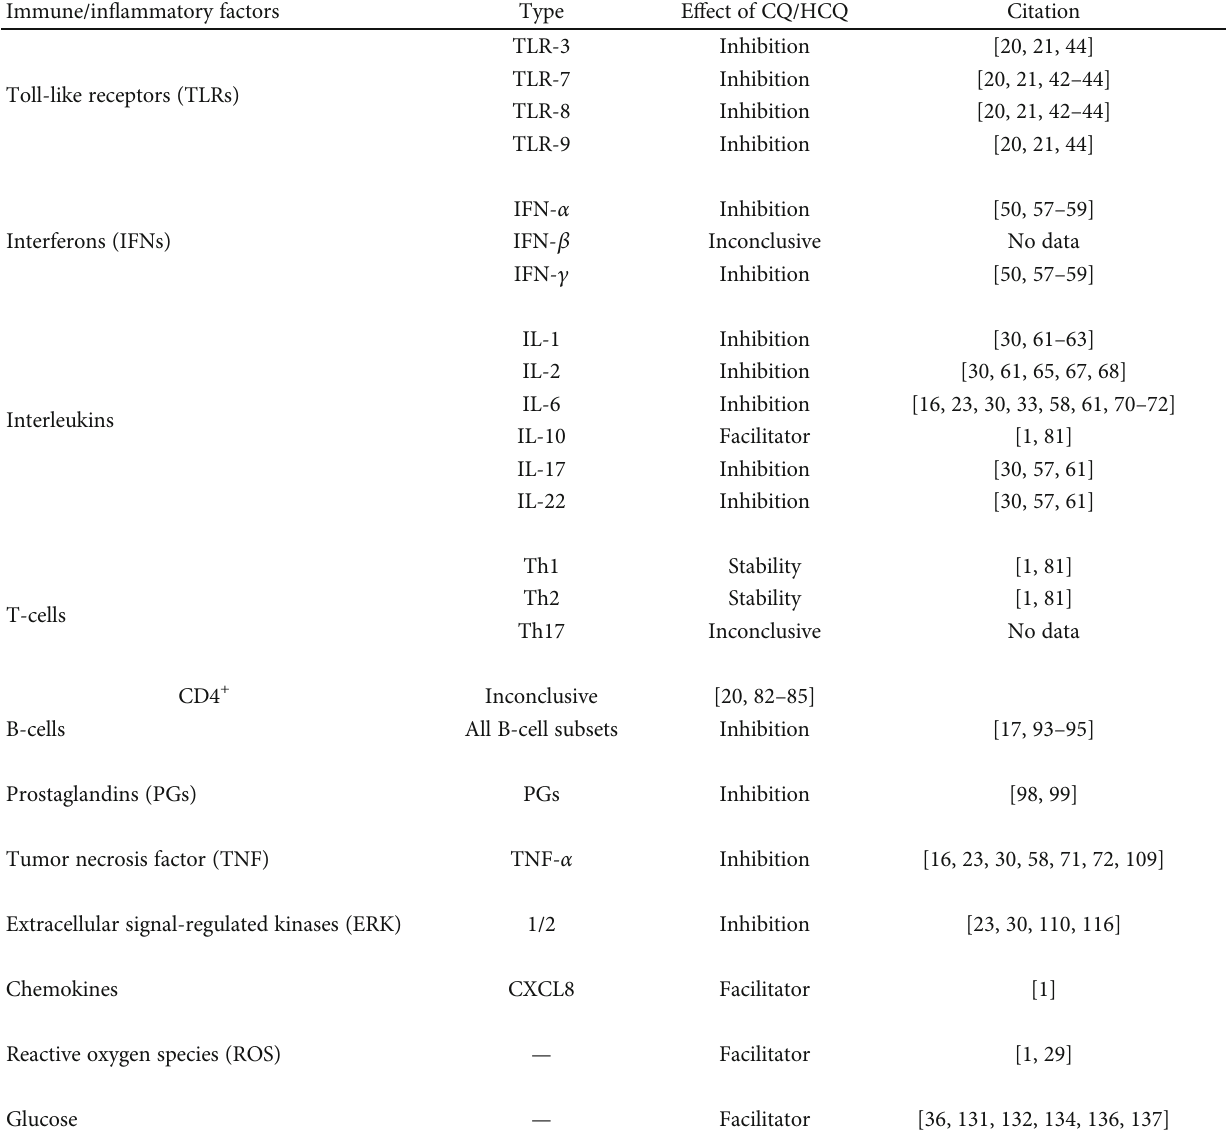
Table 1: Shows the explicit e ff ect of CQ or HCQ on various immune/in fl ammatory